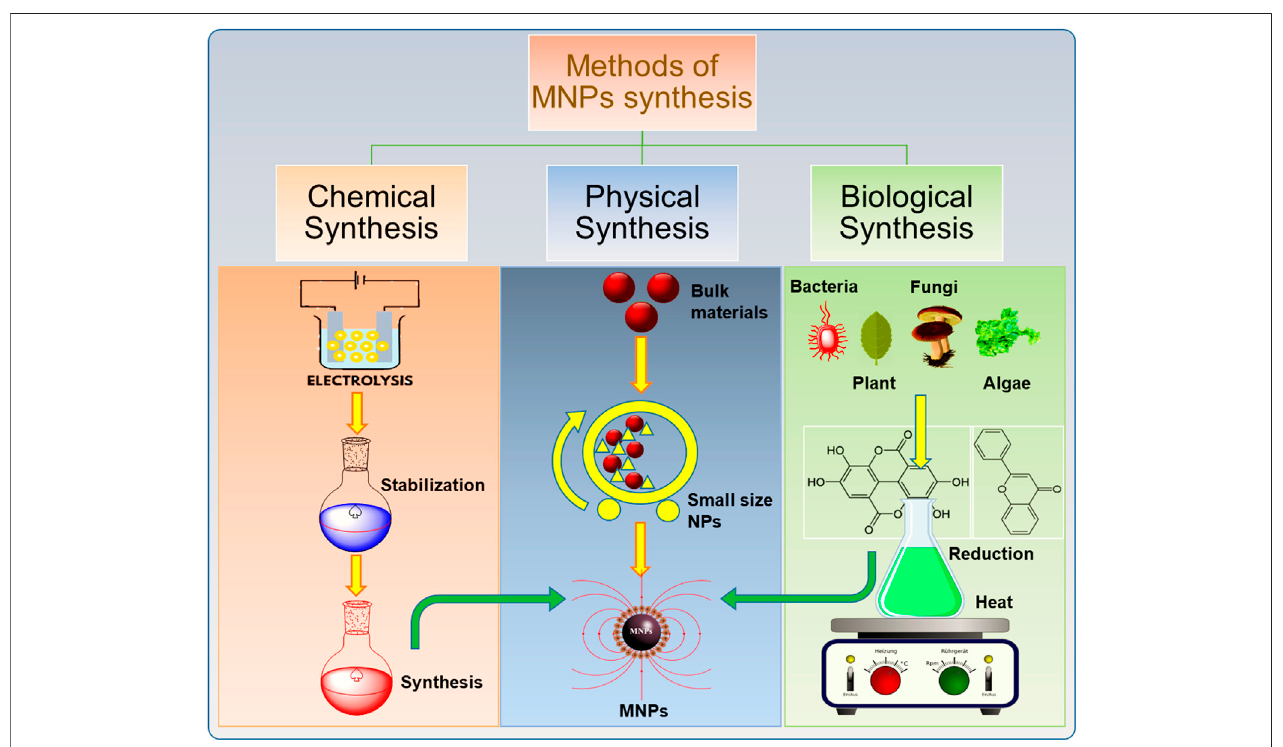
FIGURE 1 | Schematic illustration of the synthesis of magnetic nanoparticles (MNPs) with different methods.